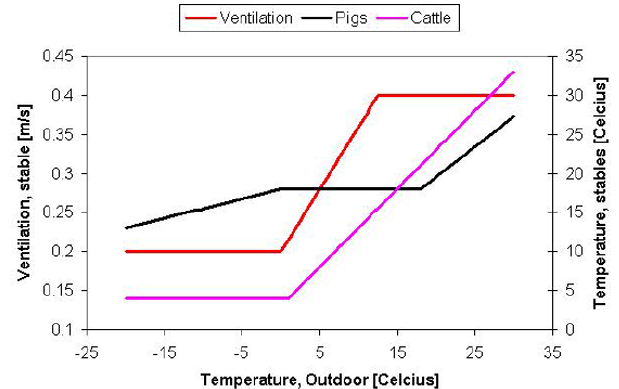
Fig. 2. The indoor temperature as function of outdoor ambient tem- perature for isolated stables (black) and open barns (pink). Isolated stables have a less steep increase in indoor temperatures because the ventilation rate (red) in these stable systems depends on outside